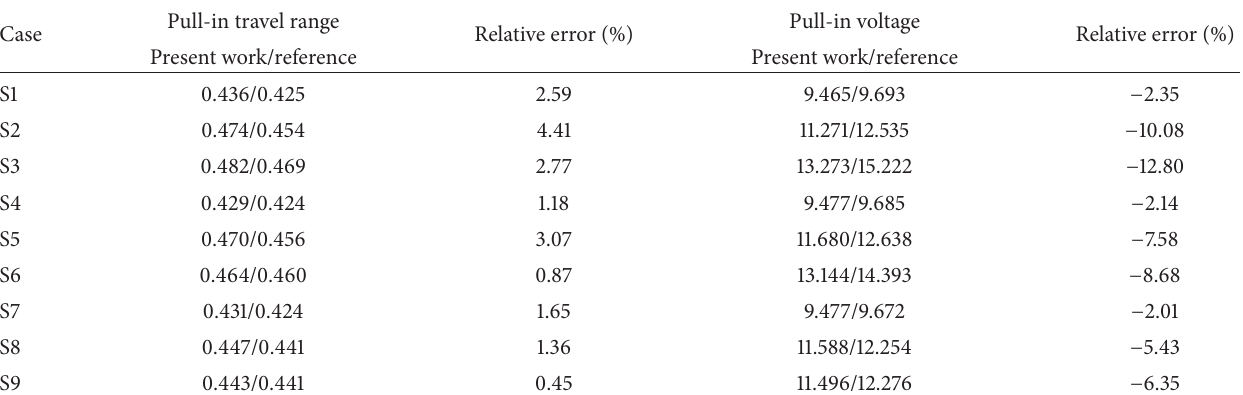
Table 2: Comparison of pull-in parameters of the optimized microbeam (reference prismatic microbeam’s pull-in travel range: 0.4028/0.405, pull-in voltage: 8.426/8.383).